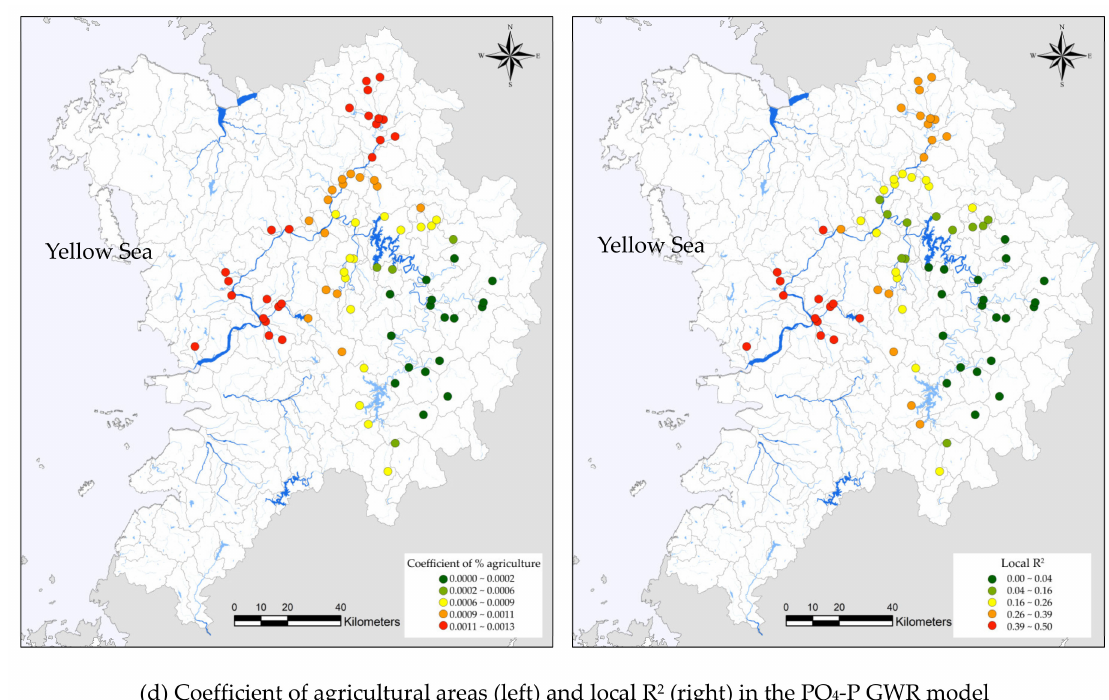
Figure 3. Spatial distribution of land use coe ffi cient and local R 2 in the estimated GWR models for BOD ( a ), DO ( b ), NH 3 -N ( c ), and PO 4 -P ( d ). The GWR model showed significant spatial variation of the land use coe ffi cient and local R 2 .